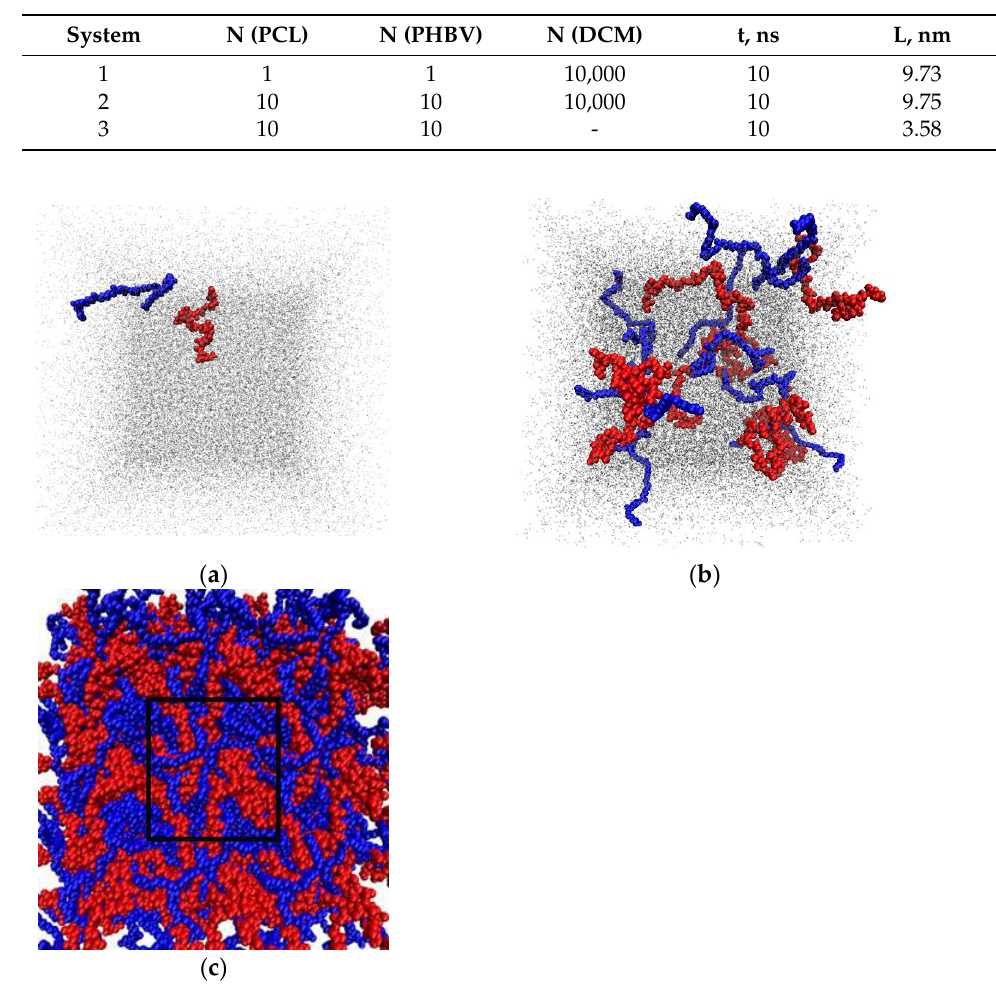
Figure 21. Snapshots of the systems under study at the end of the simulation: System 1 ( a ); System 2 ( b ); System 3 ( c ). PCL is shown in blue, PHBV in red, and DCM in grey. Based on the simulation results, average values of the radius of gyration and end-to-end distance of the polymer macromolecules were calculated (Table 8), as well as the number of close contacts of the polymer atoms within 0.5 nm (Table 9) (averaging was carried out over the last 5 ns of the simulation). Table 8. The values of the end-to-end distance R e-t-e and radius of gyration R g for PCR and PHBV, averaged over the last 5 ns of the simulation.